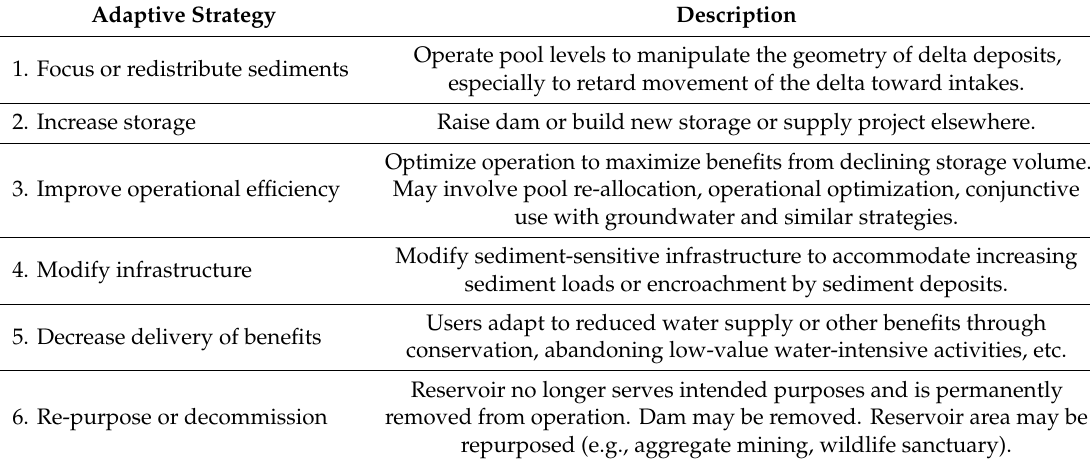
Table 4. Adaptive Strategies Responding to Sedimentation